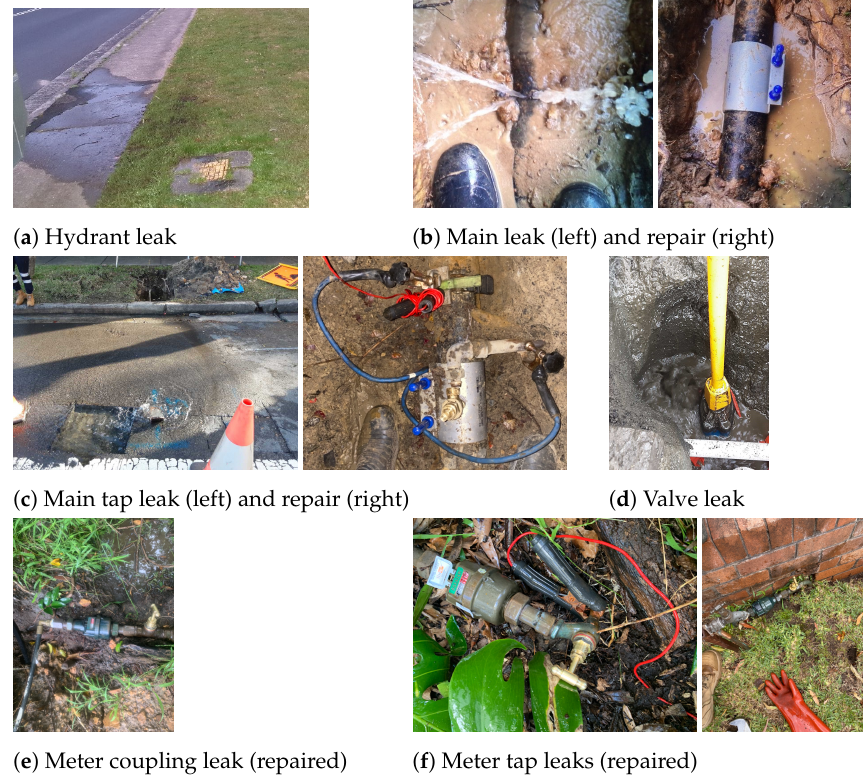
Figure 3. Examples of validated leaks from L&S logger